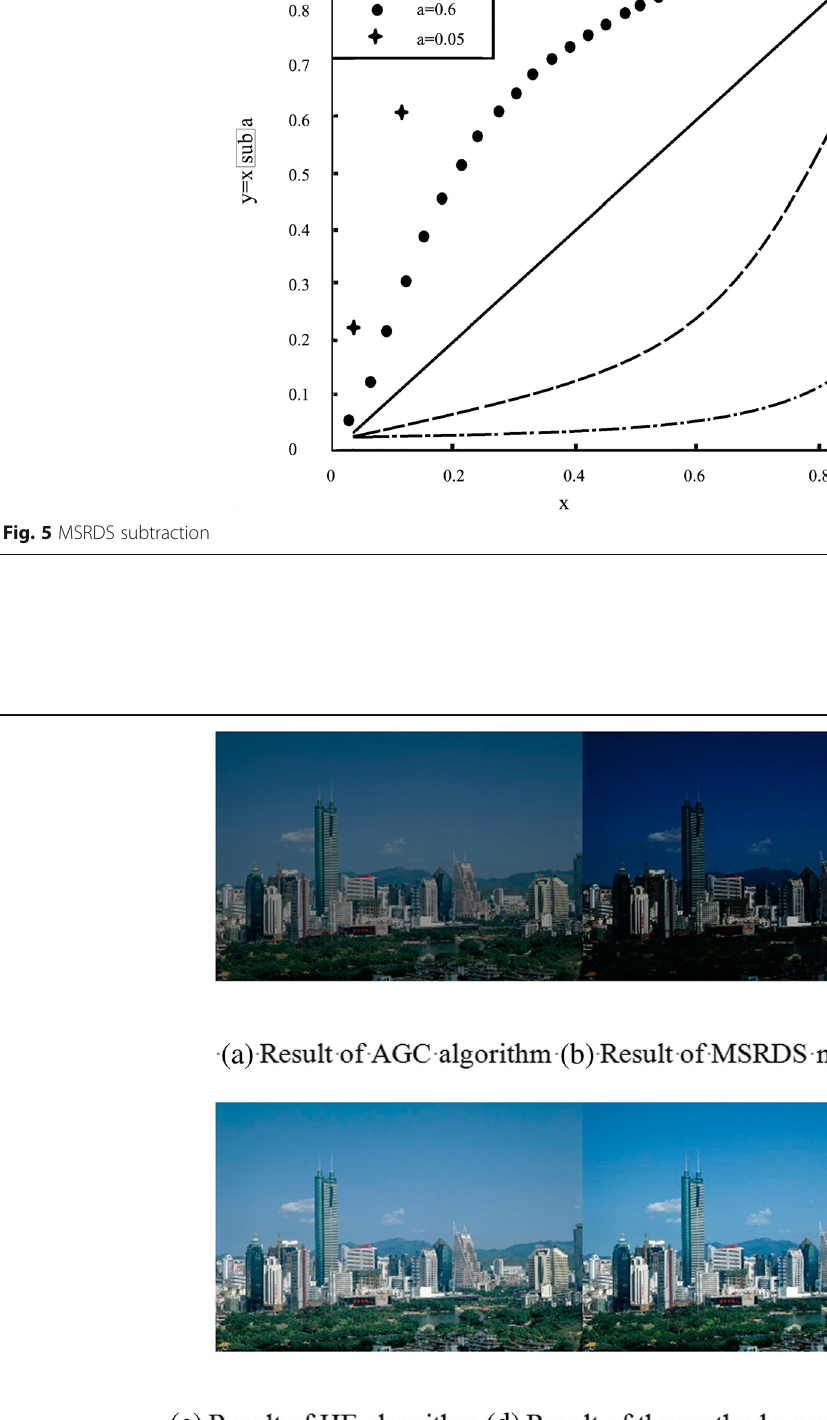
Fig. 6 a – d Comparison of the algorithms for outdoor long-distance